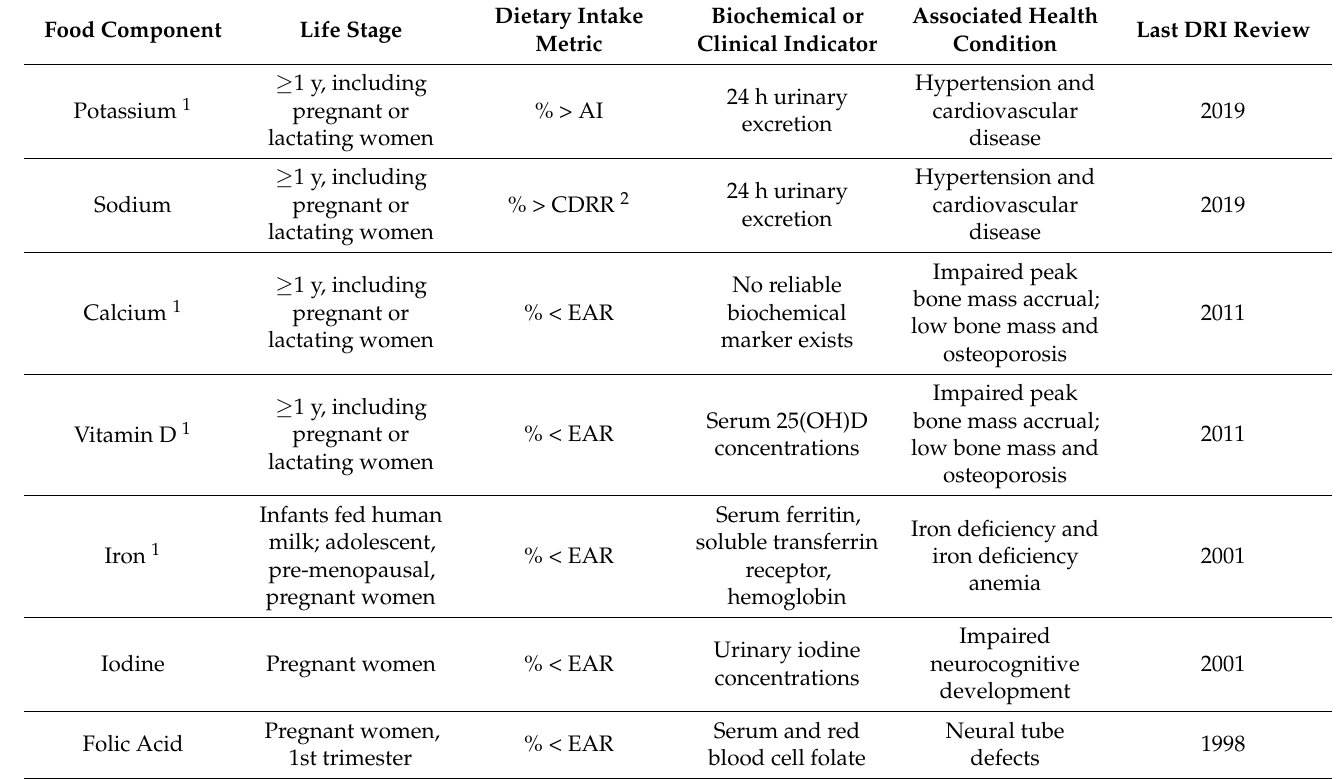
Table 1. Select food components (nutrients) of public health concern with summary by life stage. Adopted from Dietary Guidelines Advisory Committee (2020)